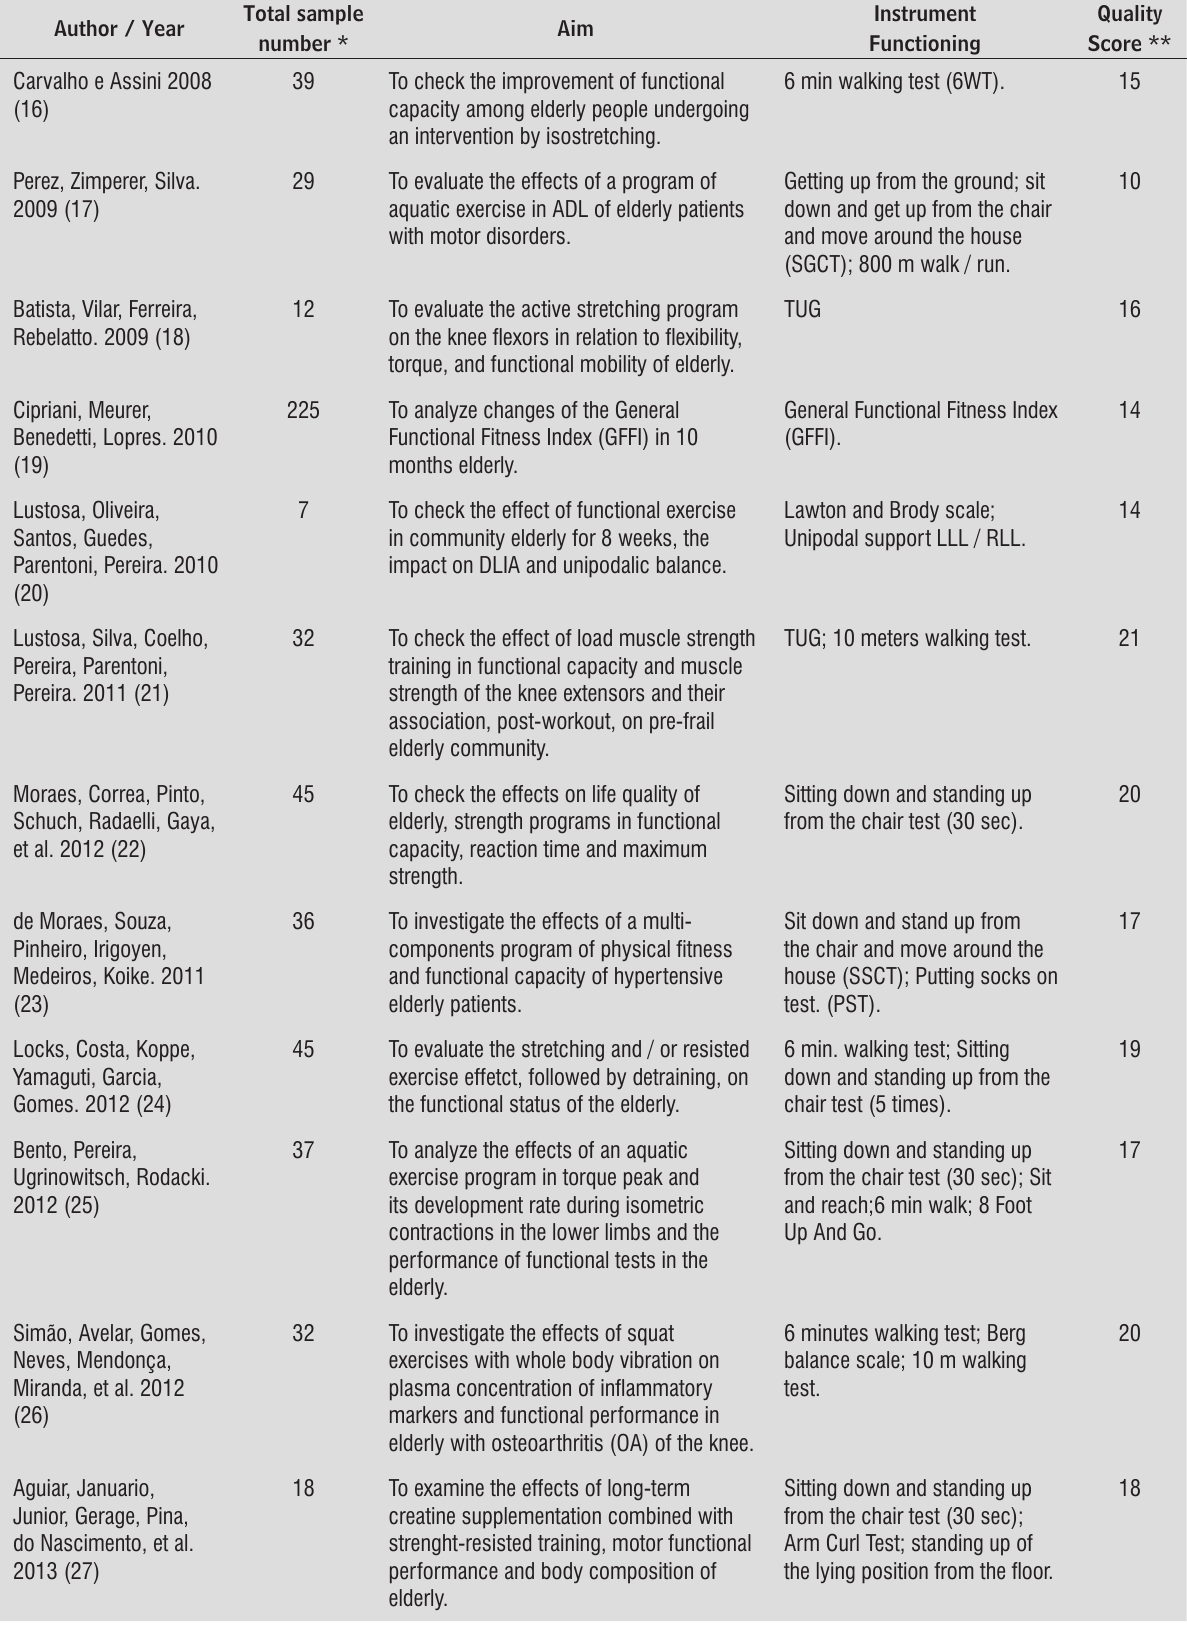
elderly with osteoarthritis (OA) of the knee. To examine the effects of long-term creatine supplementation combined with